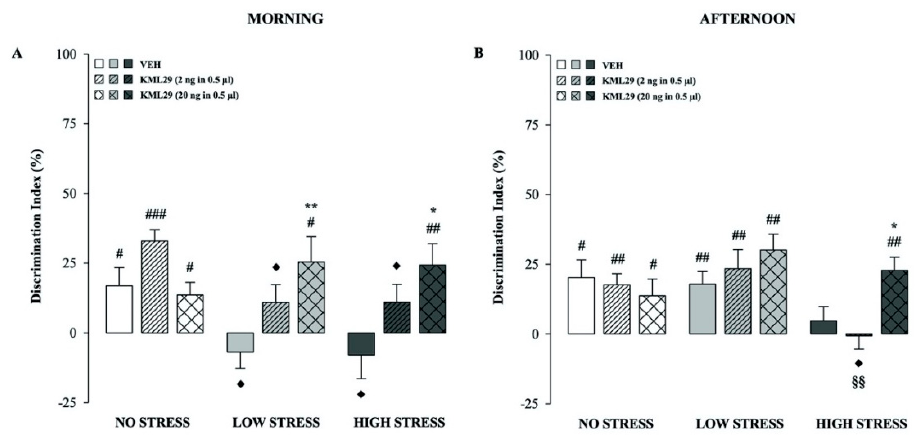
Figure 4. KML29 modulation of stress - and time-of-day - dependent effects on short-term memory . Discrimination index on the testing trial for rats that were administered in the CA1 region of the dorsal hippocampus with either vehicle or KML29 and then subjected to no, low or high stress conditions immediately after training, in the morning ( A ) or in the afternoon ( B ). Post hoc analysis reported significant group di ff erences as follows: * p < 0.05, ** p < 0.01 vs the corresponding vehicle group. ♦ p < 0.05 vs the corresponding no stress group. §§ p < 0.01 vs the corresponding low stress group. # p < 0.05; ## p < 0.01, ### p < 0.0001, one-sample t-tests significantly different from zero. Data are expressed as mean ± SEM ( n = 10–12 per group).